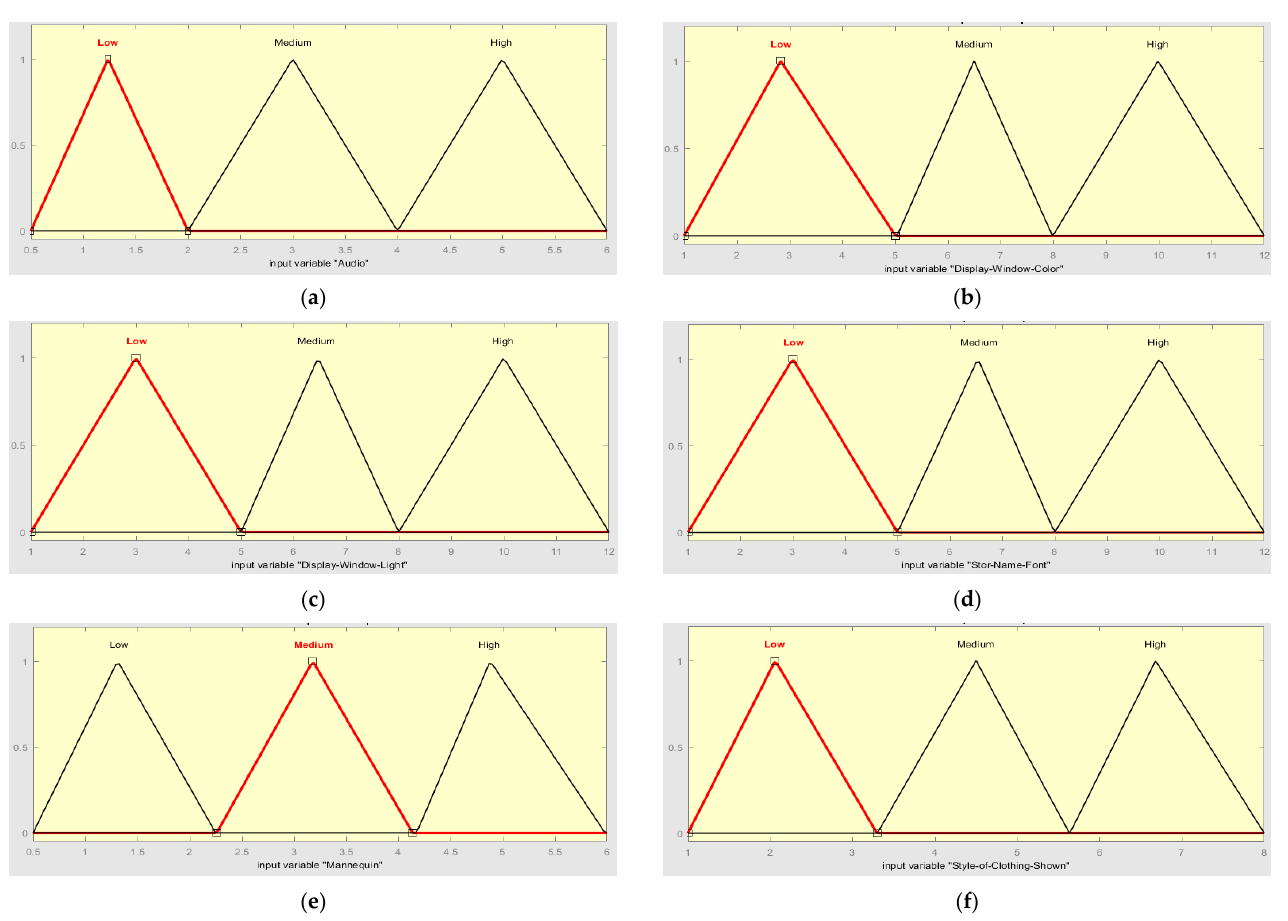
Figure 13. Triangular membership functions for fuzzy system inputs: ( a ) audio, ( b ) display window colors, ( c ) display window light, ( d ) font of the store name, ( e ) mannequins, and ( f ) clothing style.